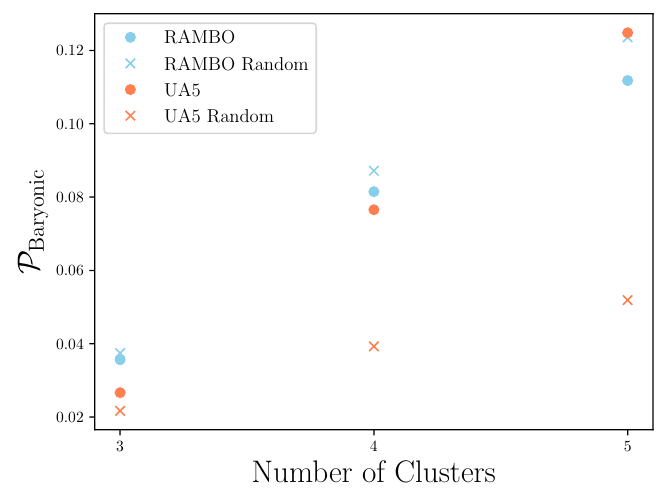
Figure 6 . The average baryonic reconnection probabilities for the RAMBO and UA5 phase space option with original and random initial colour connections.